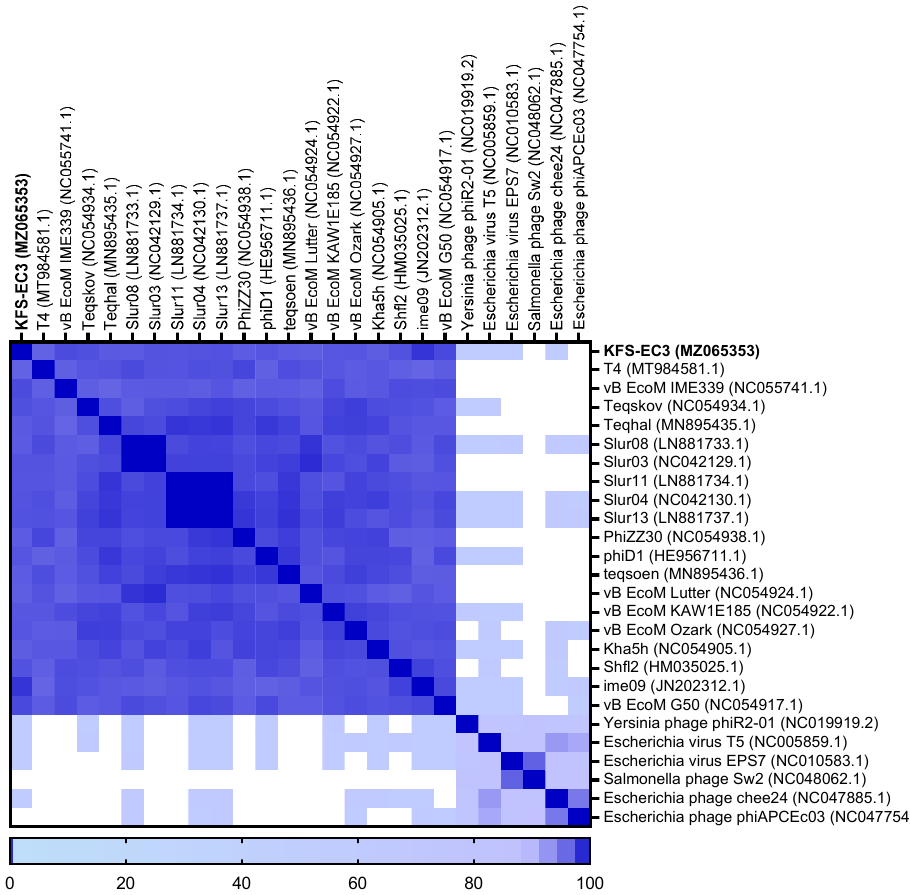
Figure 7. Heatmap analysis of the average nucleotide identity values of KFS-EC3 and other related phages in the NCBI database. Deeper shades of blue indicate a closer relationship.